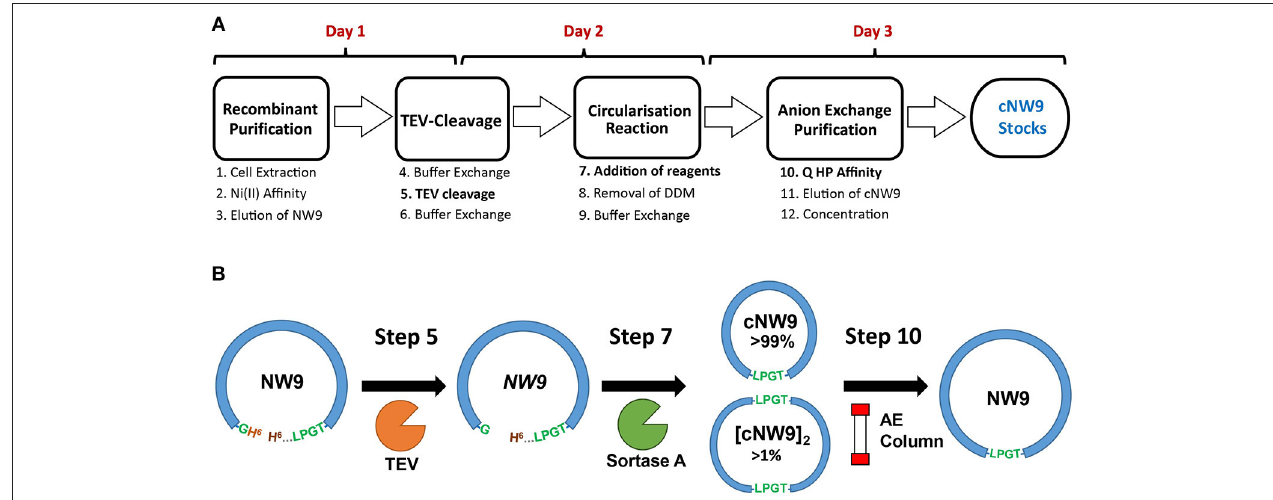
FIGURE 1 | Production and circularization of cNW9. (A) Cell extraction of recombinant, noncircular cNW9 (NW9) followed by affinity purification (Ni Sepharose resin) and TEV cleavage (day 1 and overnight). TEV-cleaved NW9 circularization to a circular monomeric product (cNW9) and multimeric by-products ([cNW9] n ) mediated by sortase A and assisted with lipid-detergents (day 2). Purification of cNW9 by anion exchange chromatography (Q HP resin) and concentration of protein stocks (day 3). (B) Reaction scheme for circularizing NW9 to cNW9 is illustrated with the key components/variants as designated in (A) (NW9, TEV, sortase A, anion-exchange column) and annotated with the key reaction steps in (A)